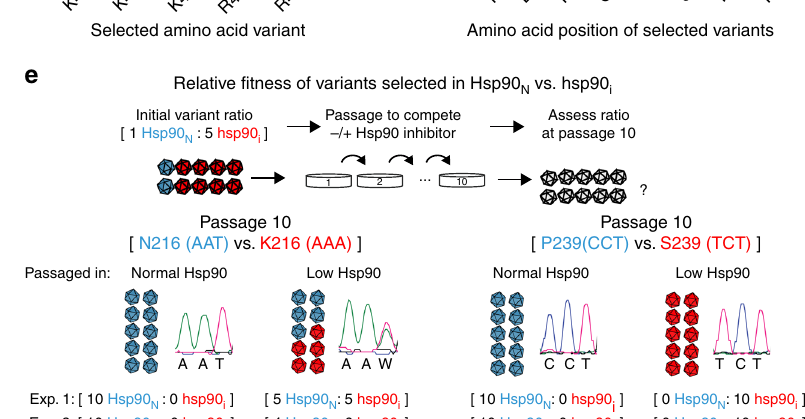
Fig. 1 Hsp90 activity in fl uences viral capsid fi tness. a Does Hsp90 activity in fl uence the sequence space of its client, poliovirus capsid protein P1? The schematic indicates a theoretical sequence space for P1 in viral populations, with each branch indicating two sequence variants linked by a point mutation. Hsp90 N and hsp90 i represent viral populations generated under normal Hsp90 activity, or under reduced Hsp90 activity by treatment with Geldanamycin (GA). WT capsids are indicated in gray, mutant capsids in color, and question marks indicate unknown capsid mutants. b Outline of capsid variants selection assay using neutralizing antibodies mAb423 and mAb427. c , d Abundance and distribution of mAb423 ( c ) or mAb427 ( d ) escape variants identi fi ed in Hsp90 N and hsp90 i populations. Each graph represents the sum of all mAb-resistant variants identi fi ed in two independent experiments (see Supplementary Fig. 1), with the total number of mutants ( n ) indicated. e Evaluation of the relative fi tness of the hsp90 i -enriched variants N216K and P239S identi fi ed in d under normal or Hsp90-inhibited conditions. An initial infection with a 1:5 ratio of Hsp90 N (N216 or P239) to hsp90 i variant (K216 or S239) virus was used, and viruses serially passaged under normal or Hsp90-inhibited conditions for 10 passages. The results of the competition assays were assessed by Sanger sequencing of the population, and is shown for passage 10. Signi fi cance: * p < 0.05, ** p < 0.01, *** p < 0.005 by two-tail Fisher ’ s exact test after multiple test correction using the false discovery rate (FDR) client protein. Given the growing interest in Hsp90 inhibitors as broad-spectrum antivirals 18,22,23 , the effect of Hsp90 on the fi t- ness of escape mutants from immune selection may have important therapeutic implications. the functional sequence space of a protein (Fig. 2a). The fi rst (no-effect ; Fig. 2a, left panel), is negated by the experiments in Fig. 1. The second model stems from the role of Hsp90 and other – 30 (buffers chaperones in buffering destabilizing mutations 9,25 mutations; Fig. 2a, middle panel). This buffering model, which remains controversial 31 , predicts that Hsp90 inhibition will